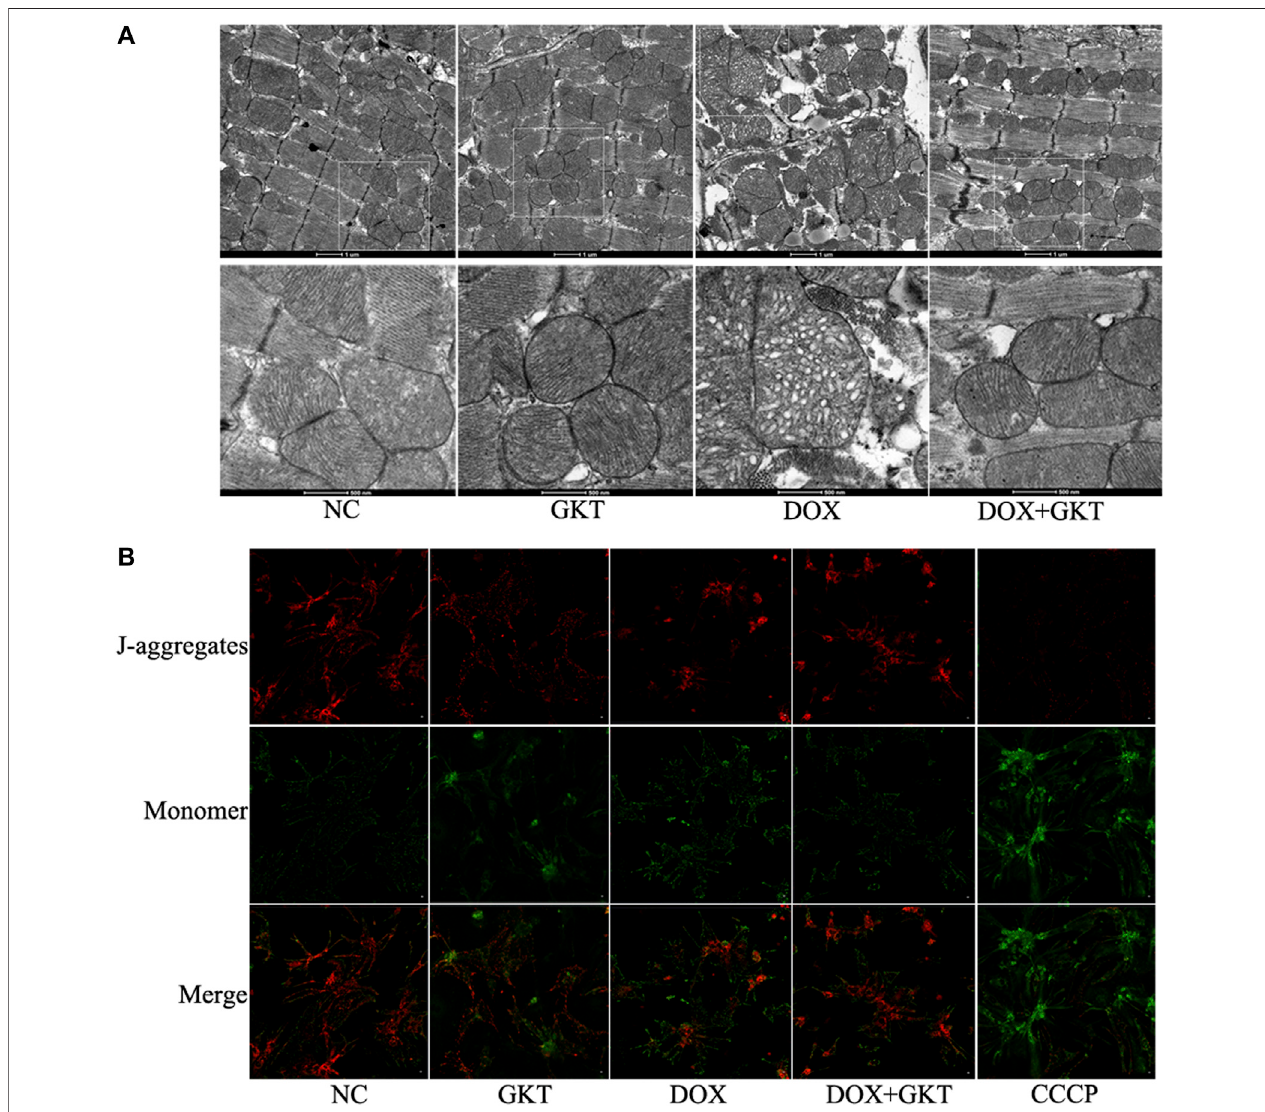
FIGURE 4 | GKT137831 alleviated DOX-induced mitochondrial damage both in vivo and in vitro . (A) Representative transmission electron microscopy image of cardiacmitochondrialultrastructure. (B) MitochondrialmembranepotentialmeasuredwithJC-1staining(scalebar=50 µm).CCCPwasusedasapositivecontrol.DOX, doxorubicin; GKT, GKT137831; CCCP, carbonyl cyanide m-chlorophenylhydrazone.